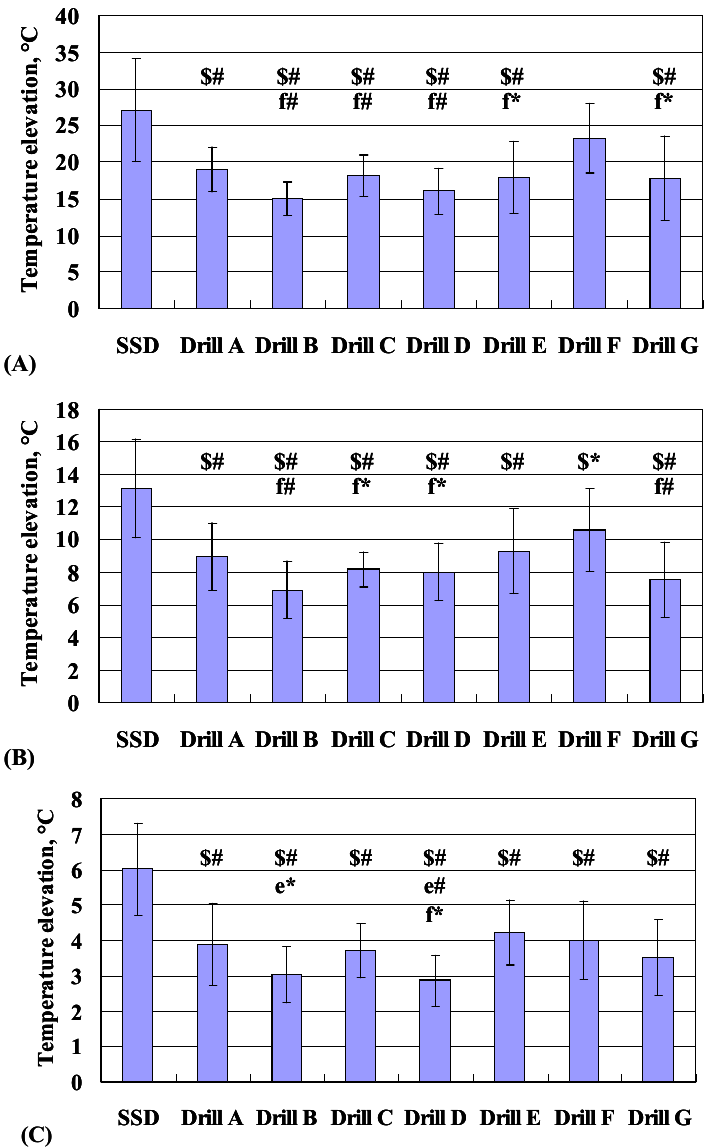
Fig. 6 Temperature elevation of the experimental drills (A) 0.7, (B) 1.5, and (C) 3.0 mm from the test hole. $, e, and f are significantly different compared to the SSD and drills E and F, respectively. * P<0.05, #